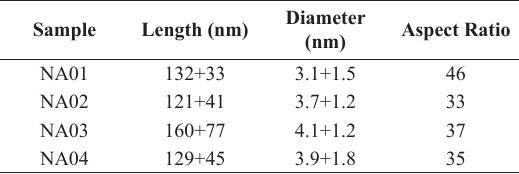
Table 3. Length, diameter and aspect ratio of the obtained cellulose nanowhiskers.